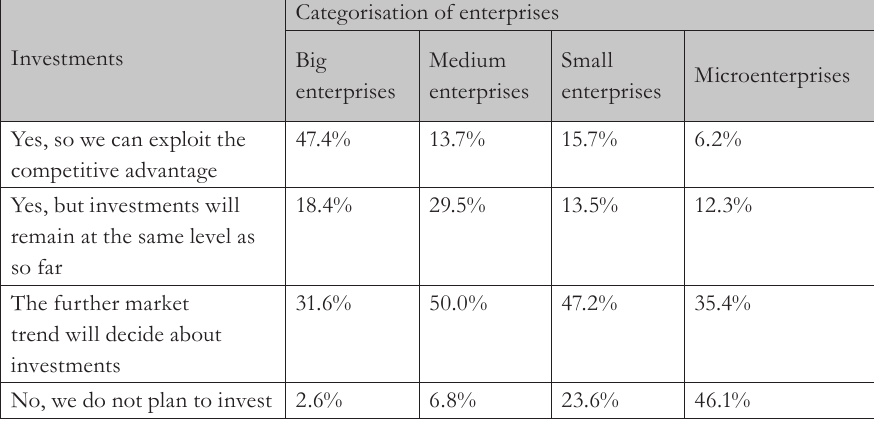
Tab. 5 – Knowledge of the concept of Industry 4.0. Source: Survey